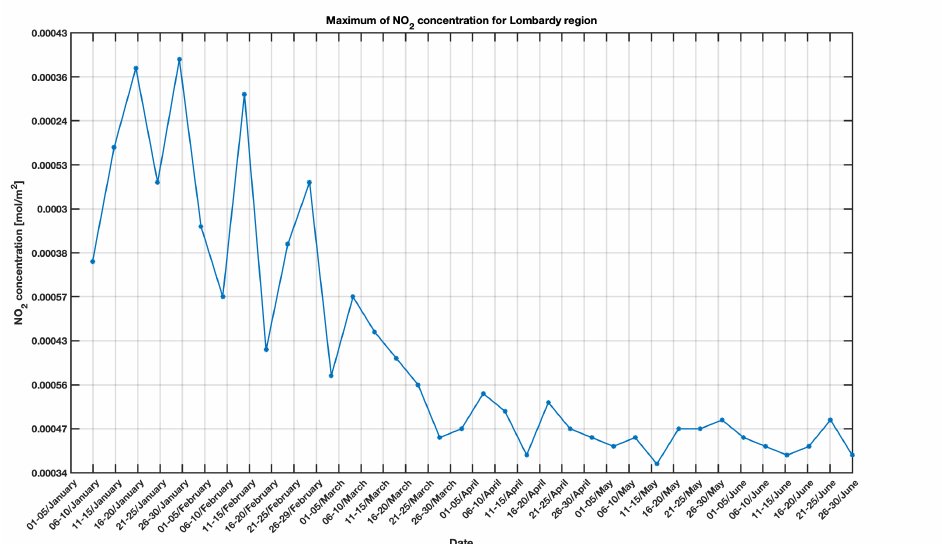
Figure 13. Maximum NO 2 concentration for Lombardy region.